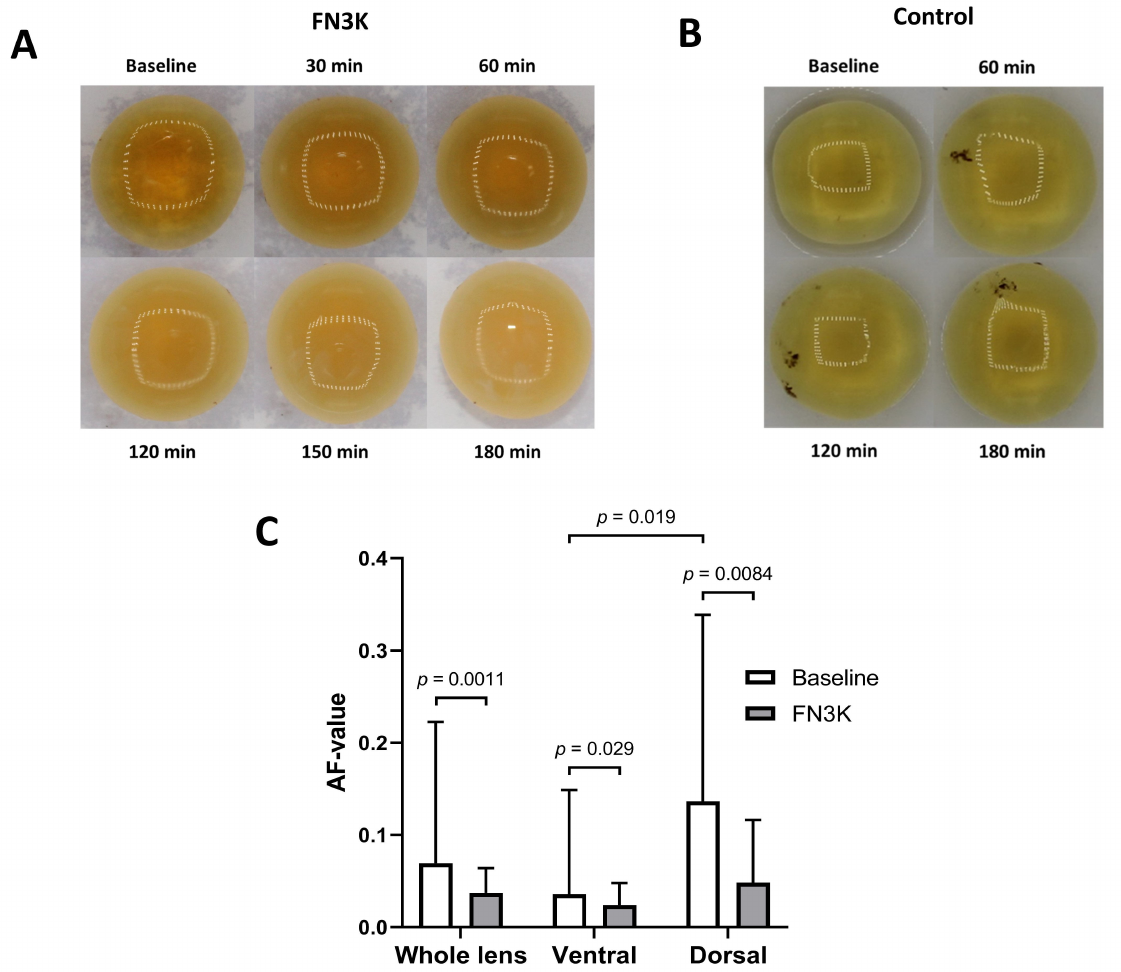
Figure 9. Time-lapse of the macroscopic changes observed after ( A ) ex vivo fructosamine-3-kinase (FN3K) treatment and ( B ) saline treatment of cataractous human eye lenses originating from two different patients. After 30 min, an improvement of the color of the cortex and homogeneity could be observed. During a follow-up in the subsequent 2.5 h, the light exposure was changed, which hampered the interpretation of color intensities in the pictures. However, independent of light exposure differences, a further amelioration of the color of the cortex and homogeneity could be observed. No remarkable macroscopic changes could be observed in the case of the saline-treated lens. ( C ) Autofluorescence (AF) values displayed as the median and interquartile range of a cataractous human eye lens at 30 different measurement locations at baseline and after FN3K treatment for the ventral, dorsal, and whole lens